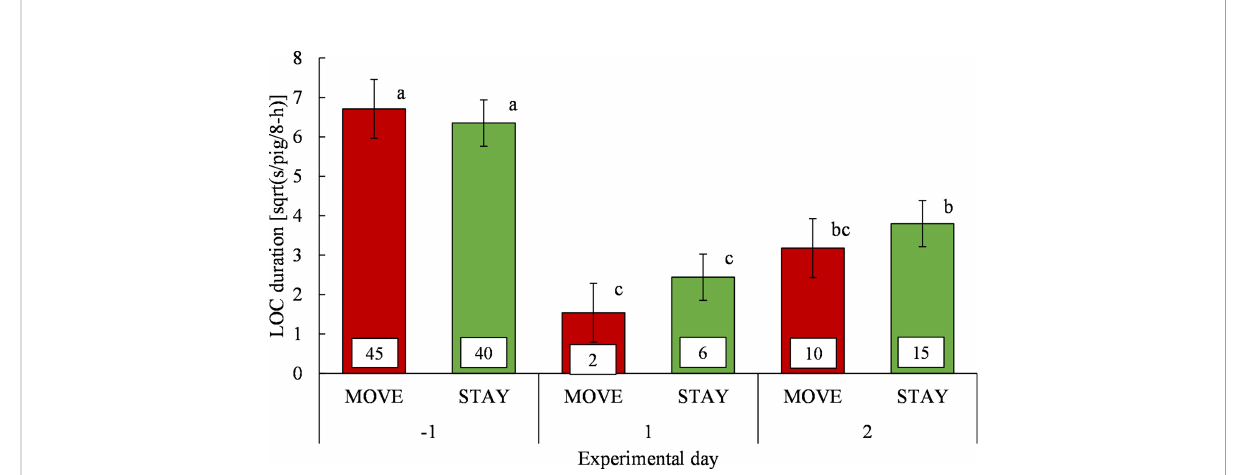
FIGURE 1 Time spent performing locomotor-rotational play (LOC), in s/pig/8-h, in pigs moved to a weaner pen (MOVE; red bars) or kept in the farrowing pen (STAY; green bars) after weaning, between 14:00 h and 22:00 h on days − 1, 1, and 2 relative to weaning. The bars represent least squares means and the error bars indicate standard error. Estimates and standard error bars were square root transformed prior to analysis, and the back-transformed least squares means are shown within a box on the top of each bar. Different superscript letters indicate statistical difference at p < 0.05 both between and within days.